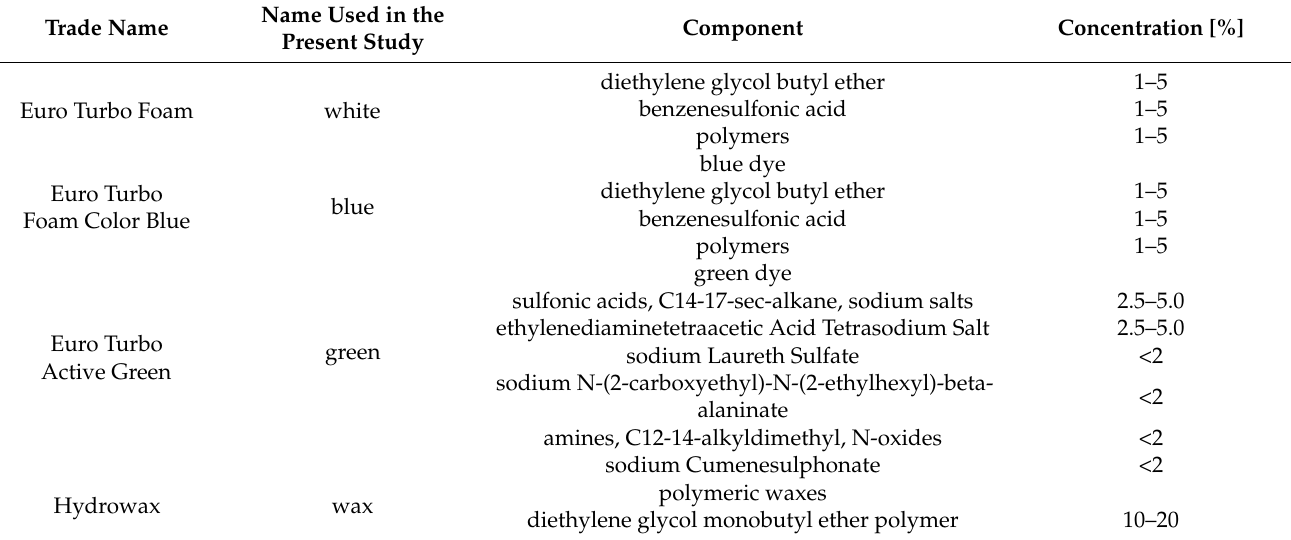
Table 2. The composition of the cleaning agents